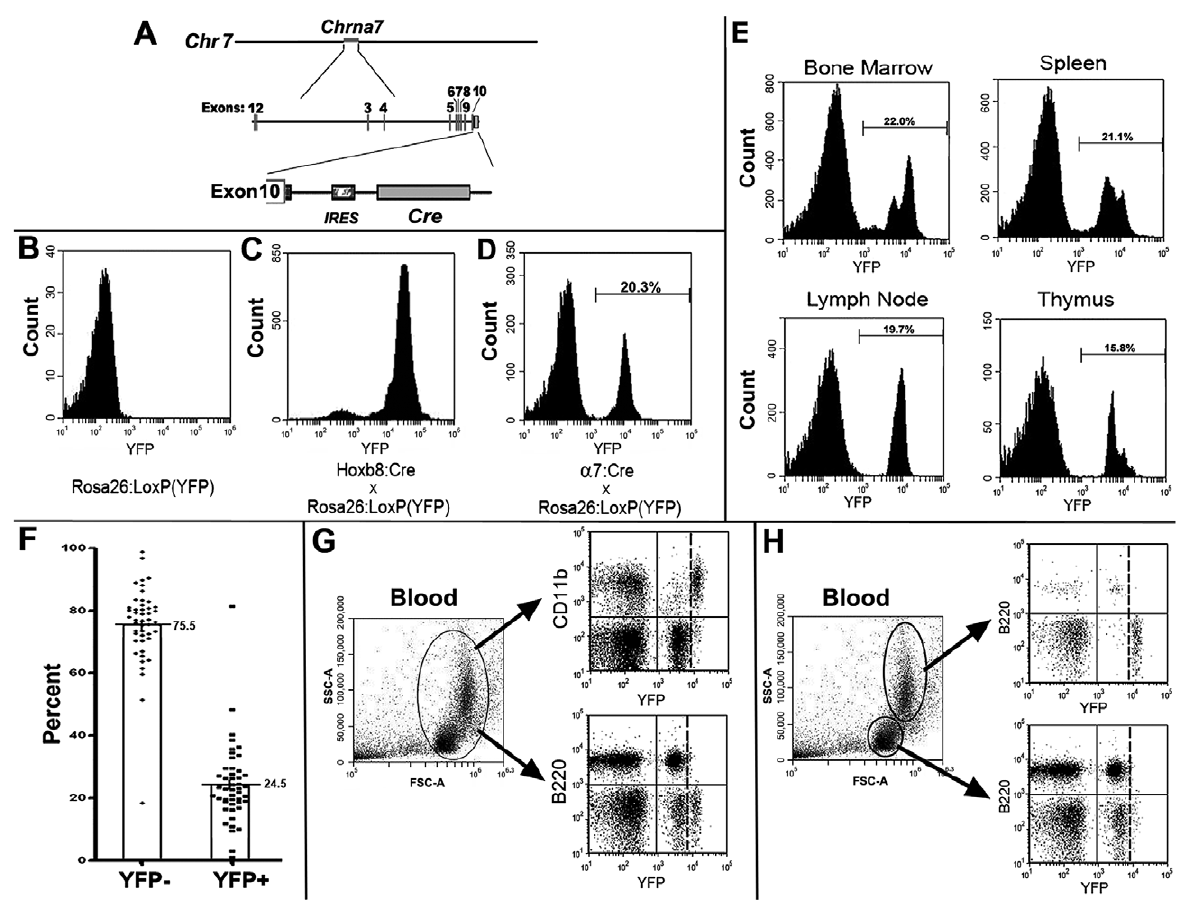
Figure 1. Description of the a 7 Cre:YFP mouse and distribution of a 7 lin + cells in lymphoid tissues. A) The a 7 Cre:YFP mouse [18] was constructed using homologous recombination to introduce into the 3 9 end of the a 7 gene ( Chrn a 7 ) a bi-cistronic marker cassette that includes an internal ribosome entry sequence (IRES) and Cre-recombinase (Cre). In these mice, the independent translation of a 7 and Cre-recombinase is achieved when Chrna7 is expressed. B) Bone marrow cells from the Rosa26:LoxP(yellow fluorescent protein (YFP)) parental mice [21,22] do not express detectable YFP but as in (C) the bone marrow cells from offspring of Hoxb8 Cre x Rosa26:LoxP(YFP) crosses exhibit . 95% YFP positive cells [22]. (D) In offspring of a 7 Cre x Rosa26:LoxP(YFP) crosses approximately 20–25% (20% for the example shown) of bone marrow cells from these mice are YFP positive ( a 7 lin + ). E) Dissociated cells from bone marrow, spleen, mesenteric lymph nodes and thymus of a 7 Cre:YFP mice were analyzed for YFP expression ( a 7 lin + ) using flow cytometry. F) A blood sample from each a 7 Cre:YFP mouse available in our colony (N=45) was analyzed for a 7 lin + positive cells. Results are expressed as percent of total cells and the mean value identified. G) Blood samples were further analyzed and a representative plot shows forward scatter (FSC) and side scatter (SSC). Cells identified for YFP expression (X axis) and co-staining for CD11b/Mac-1 or B220 are shown (Y axis). B220 + / a 7 lin + are associated with lower intensity YFP while the CD11b + cells are associated with the YFP hi . H) Upon setting gates to the indicated ovals (i.e., smaller and less granular cells), YFP lo /B220 + cells are distinguished from YFP hi /CD11b + . These experiments have been performed at least 3 times. (LSK) are present in control mice (Rosa26-LoxP(YFP)) as in the a 7 Cre:YFP mice (Figure 3A). Further, by gating on the Lin - cK- it + Sca1 + cells we determined the percentage of these cells that expressed YFP. As shown in Figure 3B, as expected no cells from the Rosa26-loxP(YFP) control mouse were YFP + . On average, 24% (24.3% + / 2 1.75%, N= 7 mice) of the Lin - cKit + Sca1 + cells from the a 7 Cre:YFP bone marrow were a 7 lin + (Figure 3B).